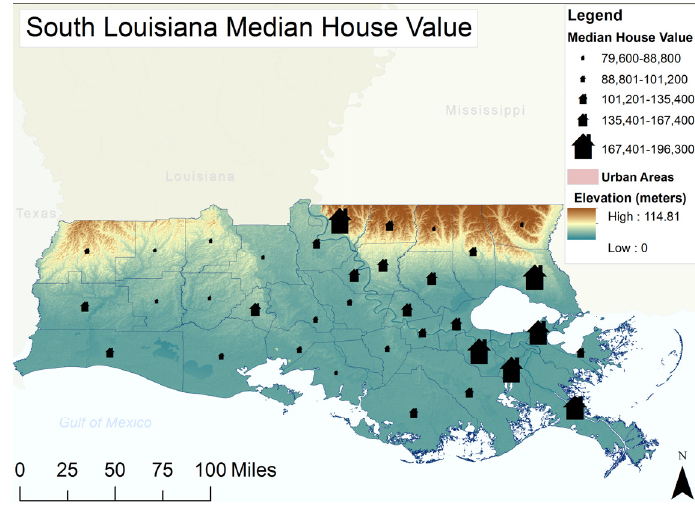
Figure 2. Map of housing values and elevations among parishes.